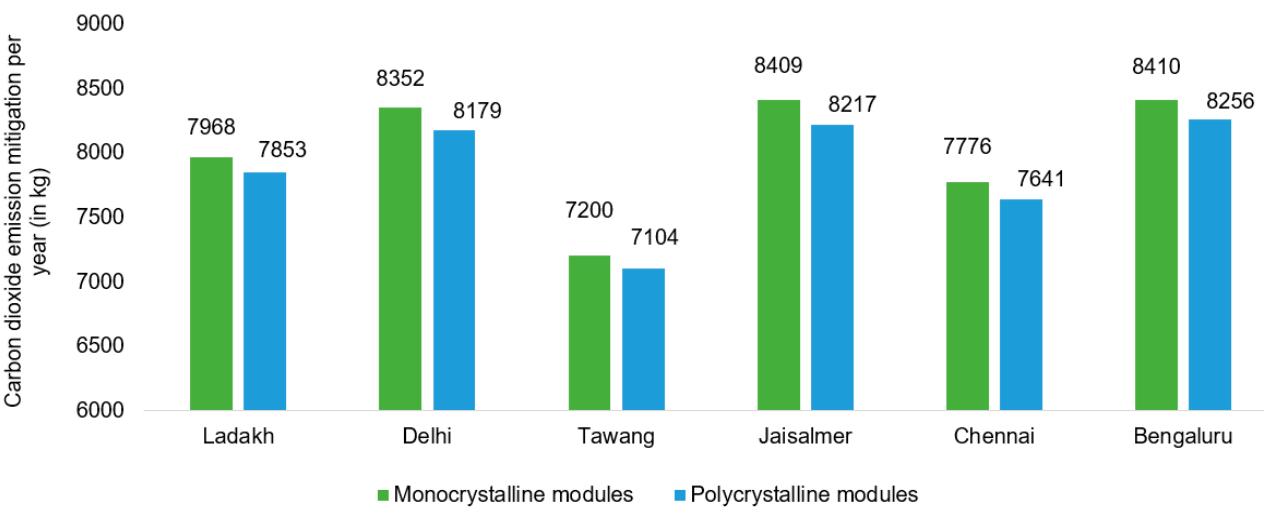
Figure 16. Reduction in CO 2 emissions by the charging station using monocrystalline and polycrystalline panels.